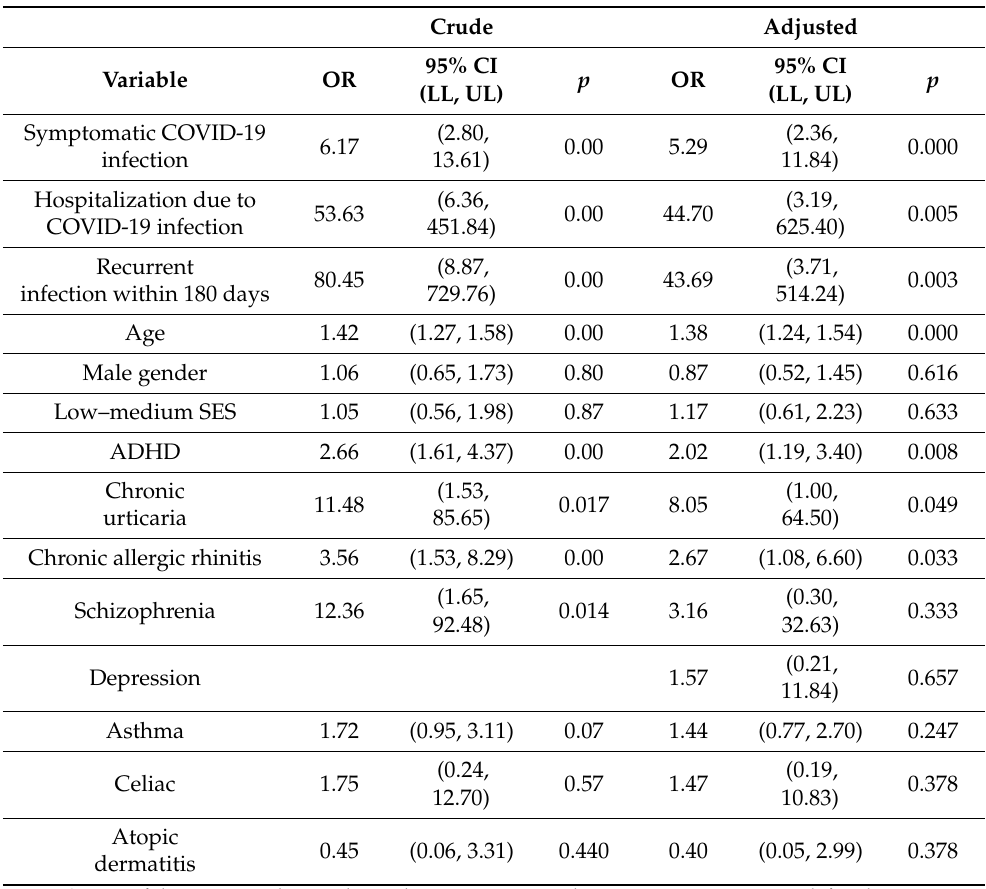
Table 3. Logistic regression for crude and adjusted odds ratios for patients with long COVID syndrome, demographic and clinical